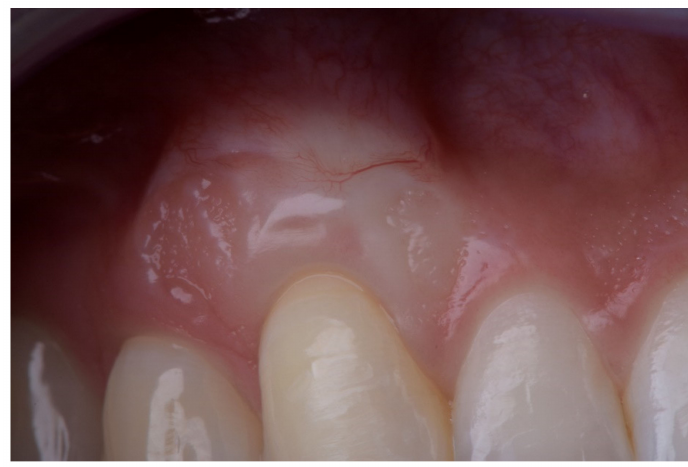
Figure 5. Superficial